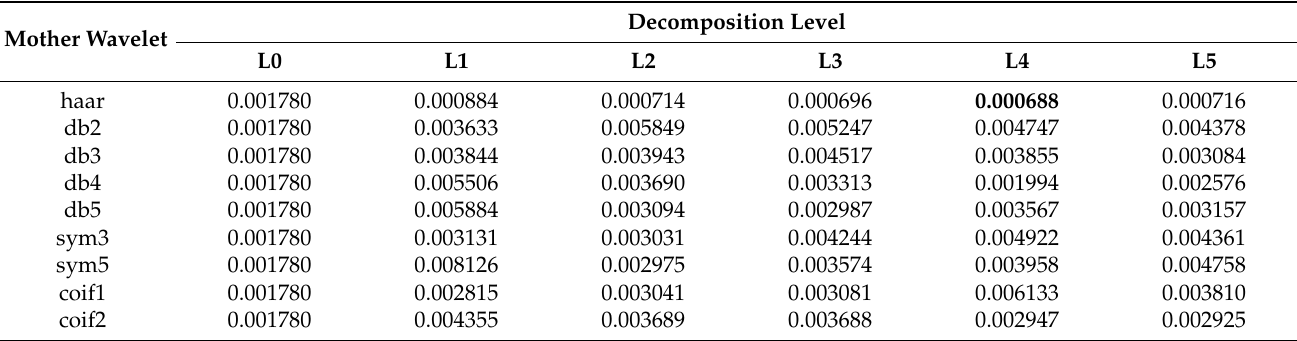
Table 2. The RMSEs using different mother wavelets and decomposition levels. Bold indicates the best